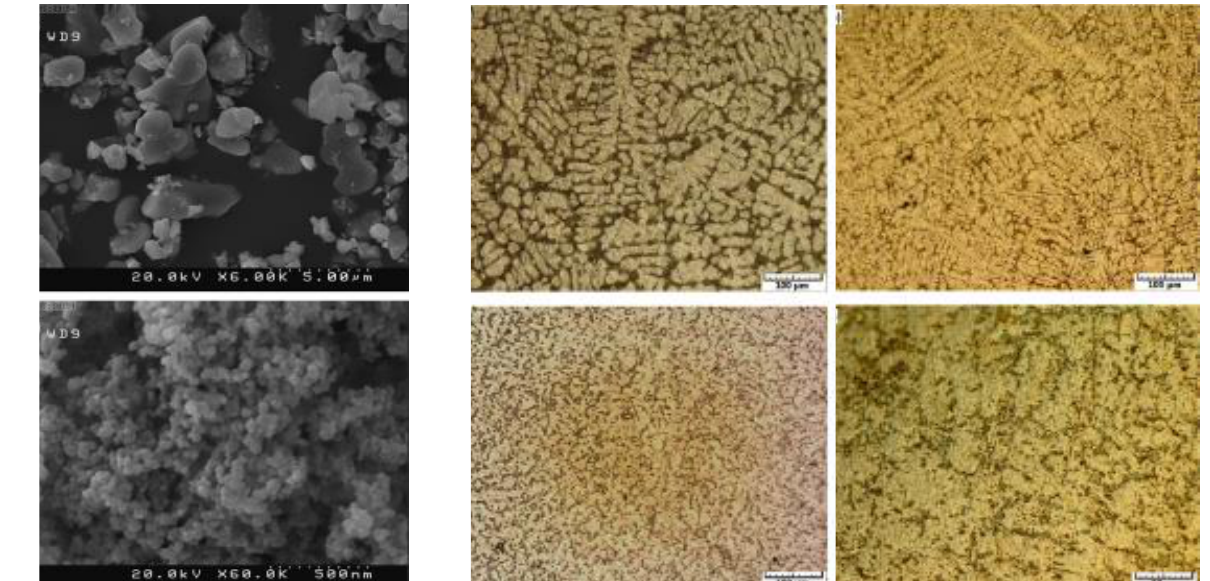
Figure 6. The micrographs of the A356-TiB 2 composite.